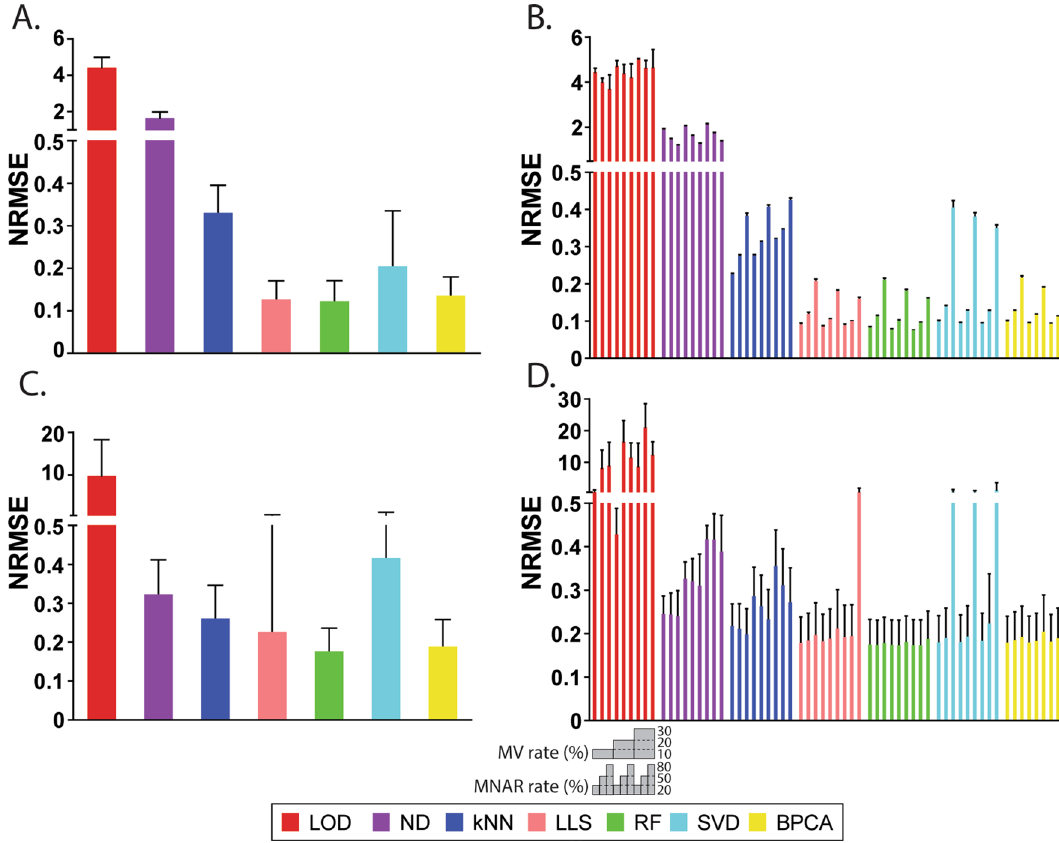
Figure 2. NRMSE of protein abundance and intergroup protein ratios with the benchmark dataset. ( A ) Overall NRMSE of protein abundances of seven imputation methods. ( B ) NRMSE of protein abundances in nine MV-MNAR conditions. ( C ) Overall NRMSE of intergroup protein ratios of seven imputation methods. ( D ) NRMSE of intergroup protein ratios in nine MV-MNAR conditions. In graph ( A ) and ( C ), bars represent average values of all ninety repeats, and error bars represent standard deviations. In graph ( B ) and ( D ), bars represent average values of ten repeats in each MV-MNAR condition, and error bars represent standard deviations. Nine MV-MNAR conditions are (from left to right): 10%MV-20%MNAR, 10%MV-50%MNAR, 10%MV-80%MNAR, 20%MV-20%MNAR, 20%MV-50%MNAR, 20%MV-80%MNAR, 30%MV-20%MNAR, 30%MV-50%MNAR,